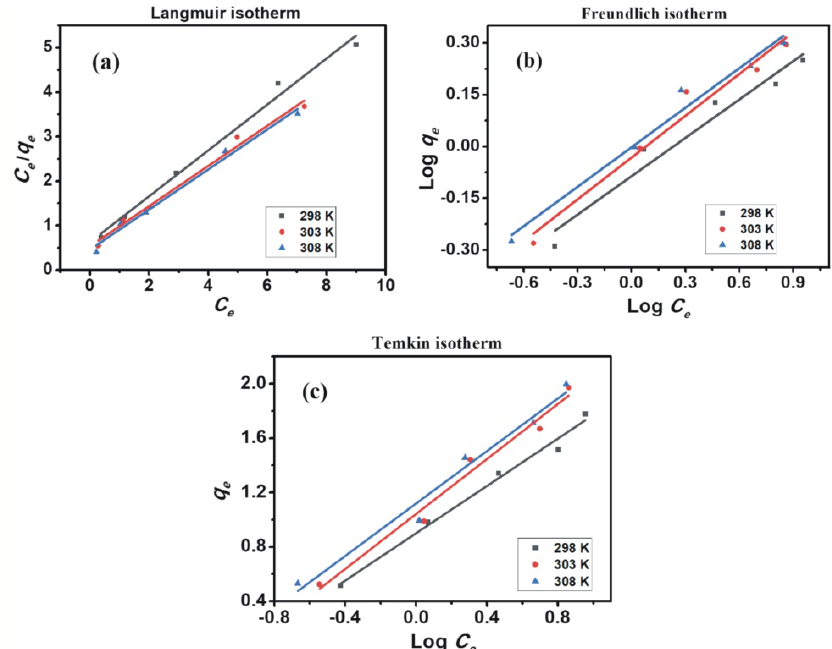
Fig. 4. (a) Langmuir isotherm, plot of C